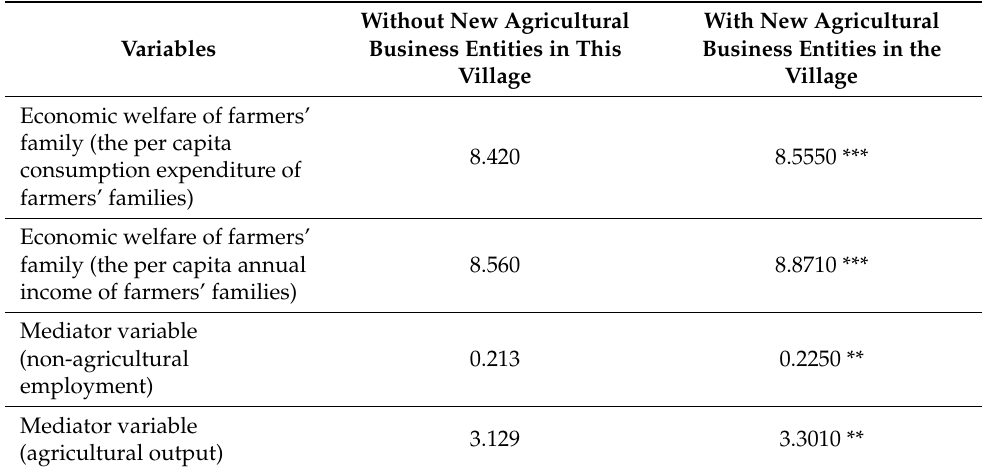
Table 2. Difference between groups of